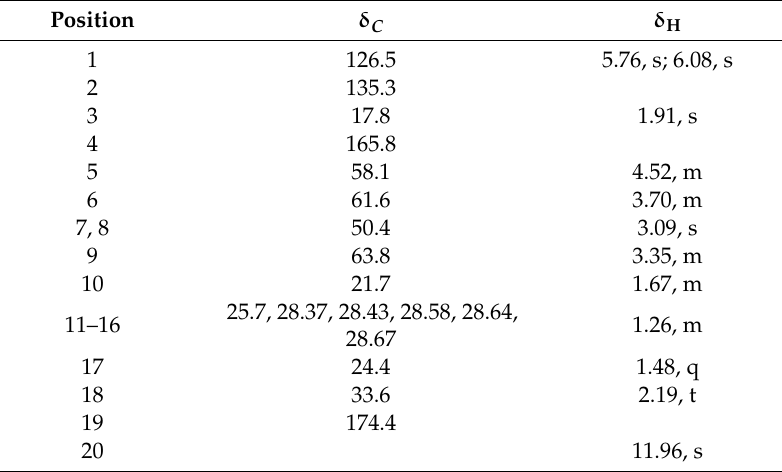
Table 2. NMR spectral peak assignments of AMadh2